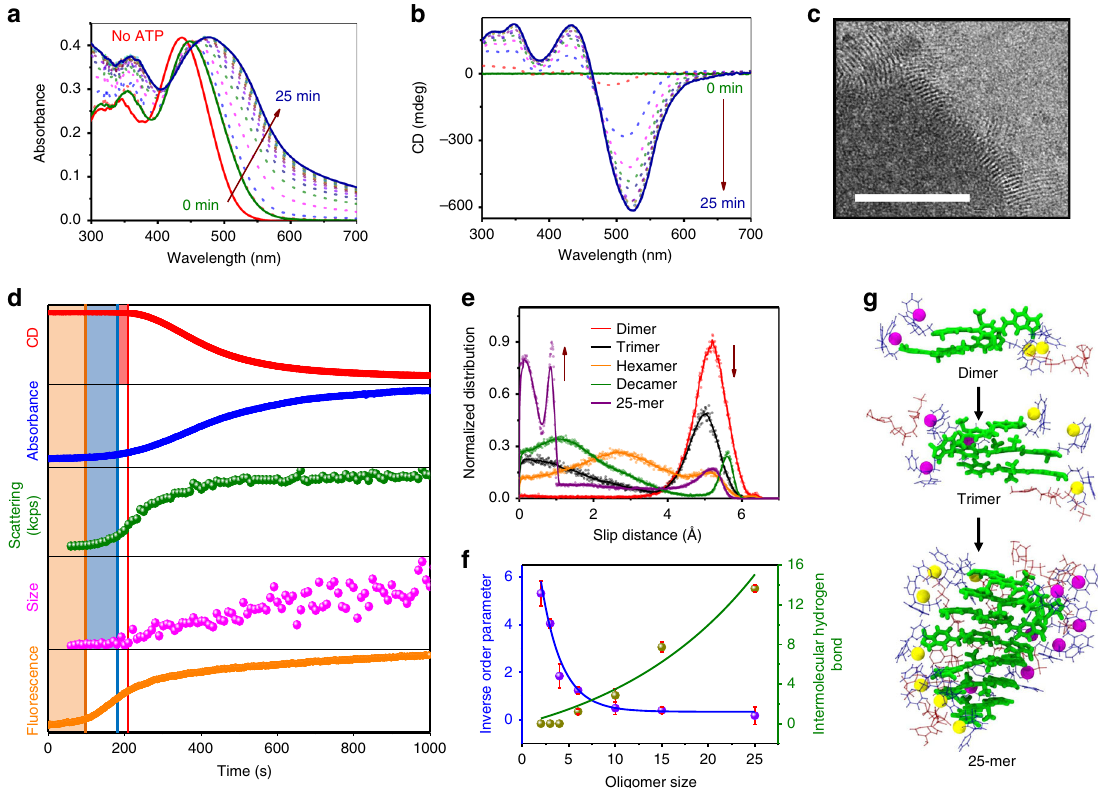
Fig. 2 ATP-driven nucleation-growth self-assembly of 1 . a UV – Vis absorbance and b CD spectra represent time lapse spectra of ATP-driven growth of 1 . c TEM showing one-dimensional assemblies of 1 (scale bar = 100 nm). d Comparison of growth kinetics and lag phases of ATP-driven nucleation growth of 1 monitored by CD (mdeg), absorbance, scattering in kcps (kilo counts per second), size (nm) obtained from dynamic light scattering (DLS) and fl uorescence. Yellow shaded area corresponds to time required for initial allosteric binding to commence; blue shaded area corresponds to time required for formation of stacks, triggered chronologically after allosteric binding of ATP to 1 , and red shaded area corresponds to lag phase after which helical ordering in stacks begins as elucidated by CD. Absorbance, CD, and emission were monitored at 500 nm ( c = 2 × 10 − 5 M, HEPES/CH 3 CN, 90/10, v/v, 0.9 equiv. ATP, 30 °C). e Slip distance distribution and f inverse order parameter (blue curve) and intermolecular H-bonds (green curve) per ATP for various oligomers extracted from MM/MD simulations of ATP- 1 stacks. The error bars were calculated using the standard error formalism, by considering the RMSD data over time as blocks. g Snapshots of MM/MD simulations of ATP- 1 oligomers showing decrease in slip distance with extent of polymerization (OPV core depicted by thick green sticks, DPA and ATP by blue and red sticks and Zn atoms as balls, with yellow on one side and magenta on the opposite, to show chirality of the